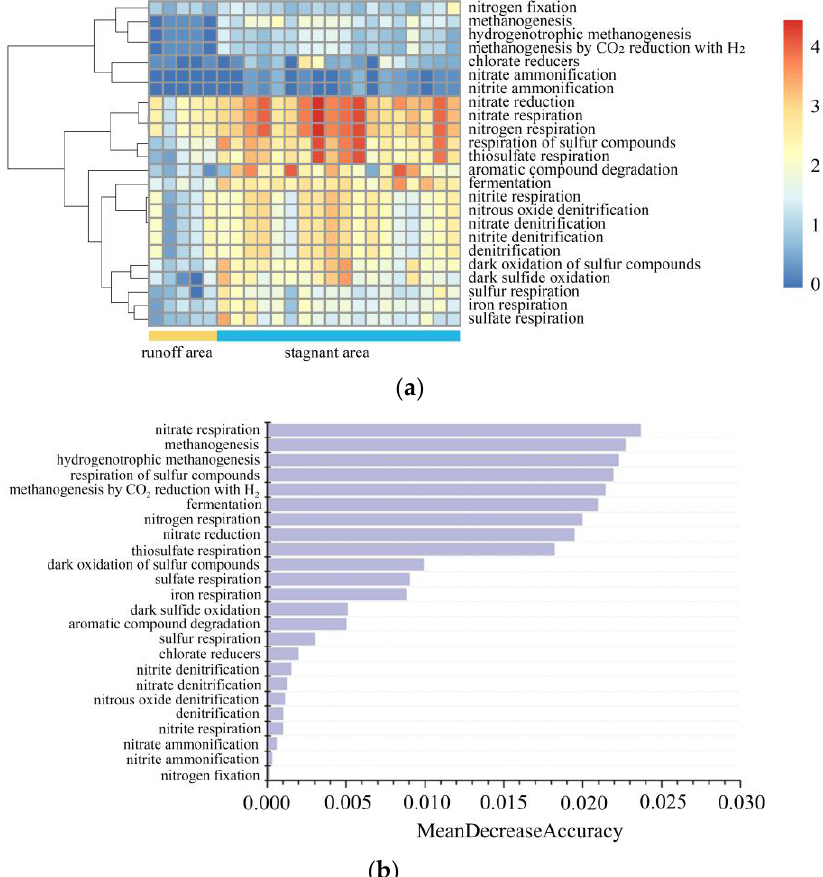
Figure 10. ( a ) Heatmap showing microorganisms’ relative abundance that changed significantly between runoff and stagnant areas; these microorganisms were chosen by machine learning calculation. The microorganisms’ relative abundance was converted to log 10 (relative abundance × 10 6 ) for better exhibition in the heatmap. ( b ) Importance ranking of MeanDreaseAccuracy calculated by randomForest packages.